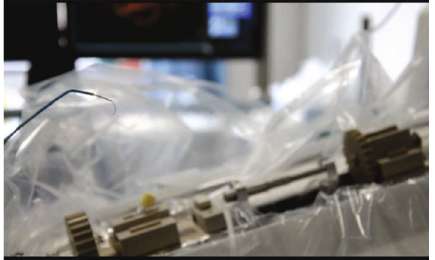
Figure 6: The robot system controls the microguidewire and microcatheter movement.